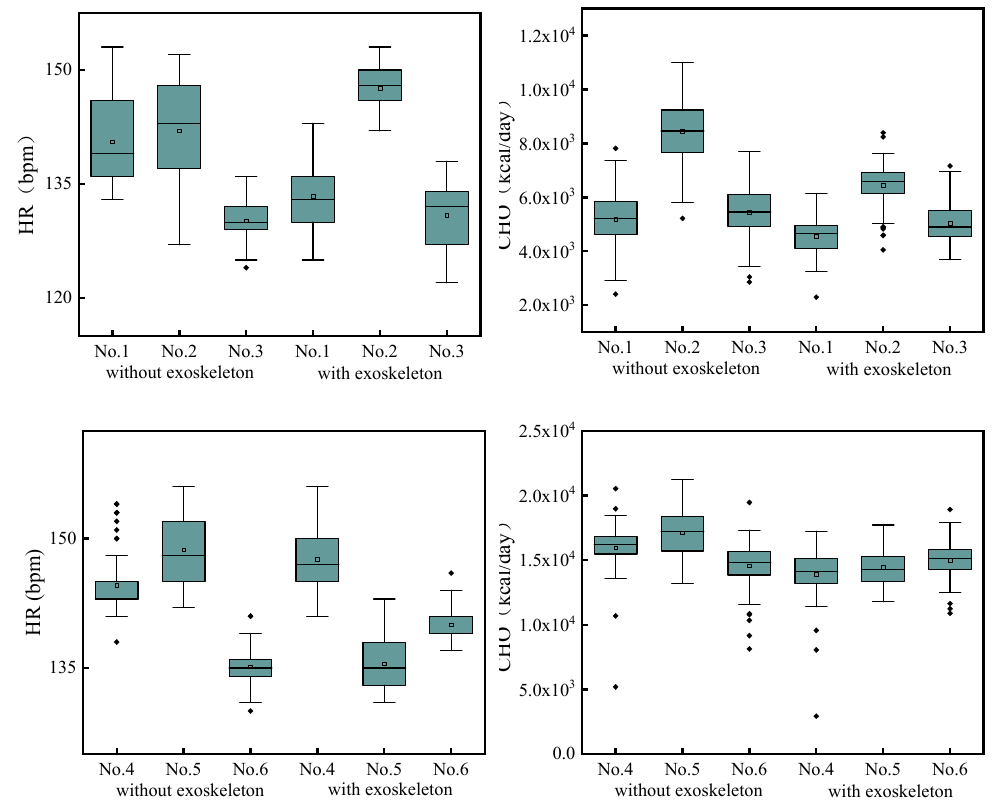
Figure 15. Measurement data under stationary motion.